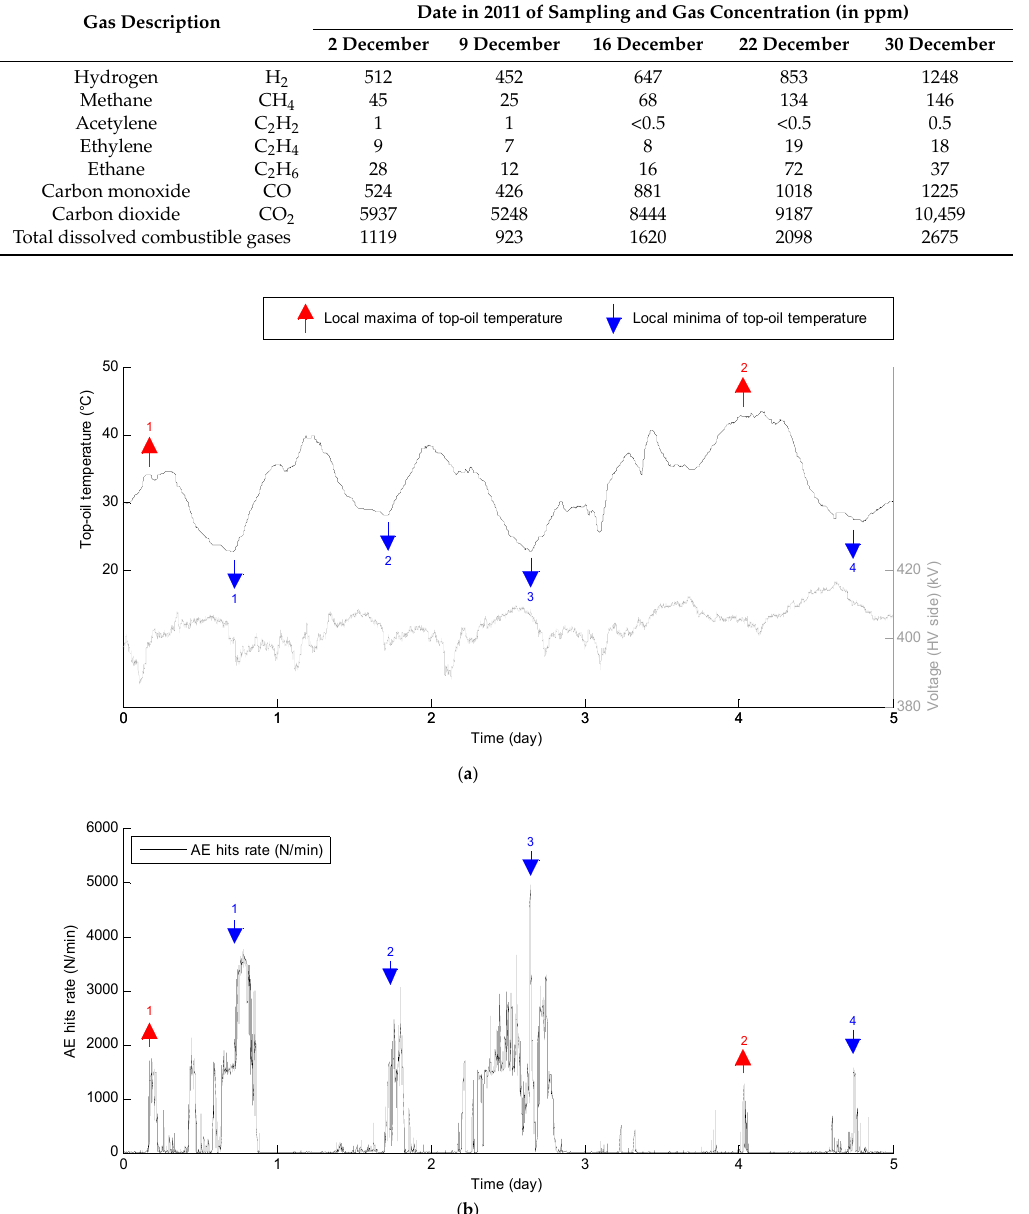
Table 1. Results of the periodic dissolved gas analysis (DGA) tests. Measurements were taken using KELMAN Transport X Portable Dissolve Gas Analyzer (General Electric, Fairfield, CT, USA).